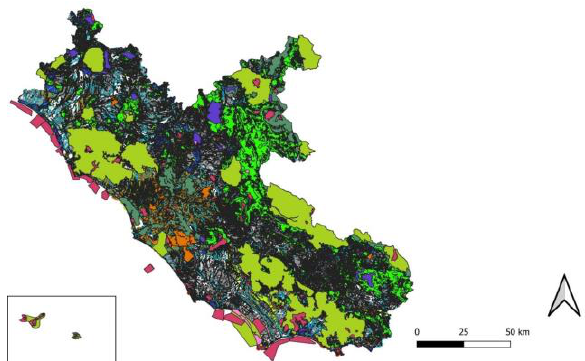
Figure 2 . Large photovoltaic map with the constraints of tables A and B; in white the not unsiuitable areas with remaining constraints (in exerpt Latium islands).